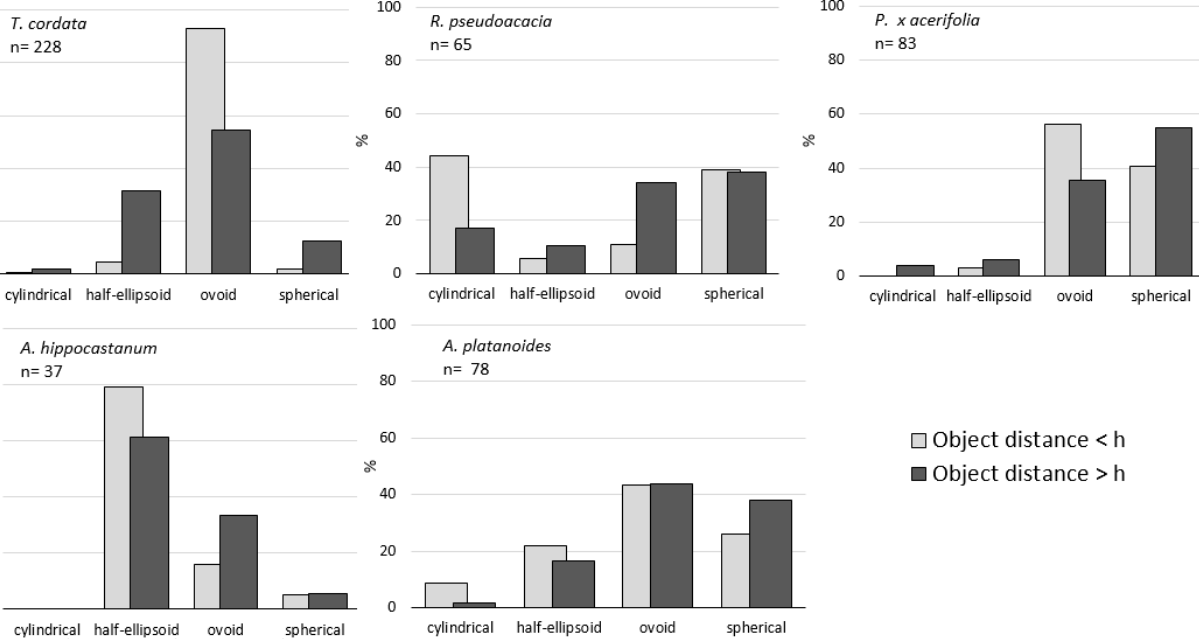
Figure 8. Percentage distribution of crown shapes for the different tree species for two distance classes of the closest object.